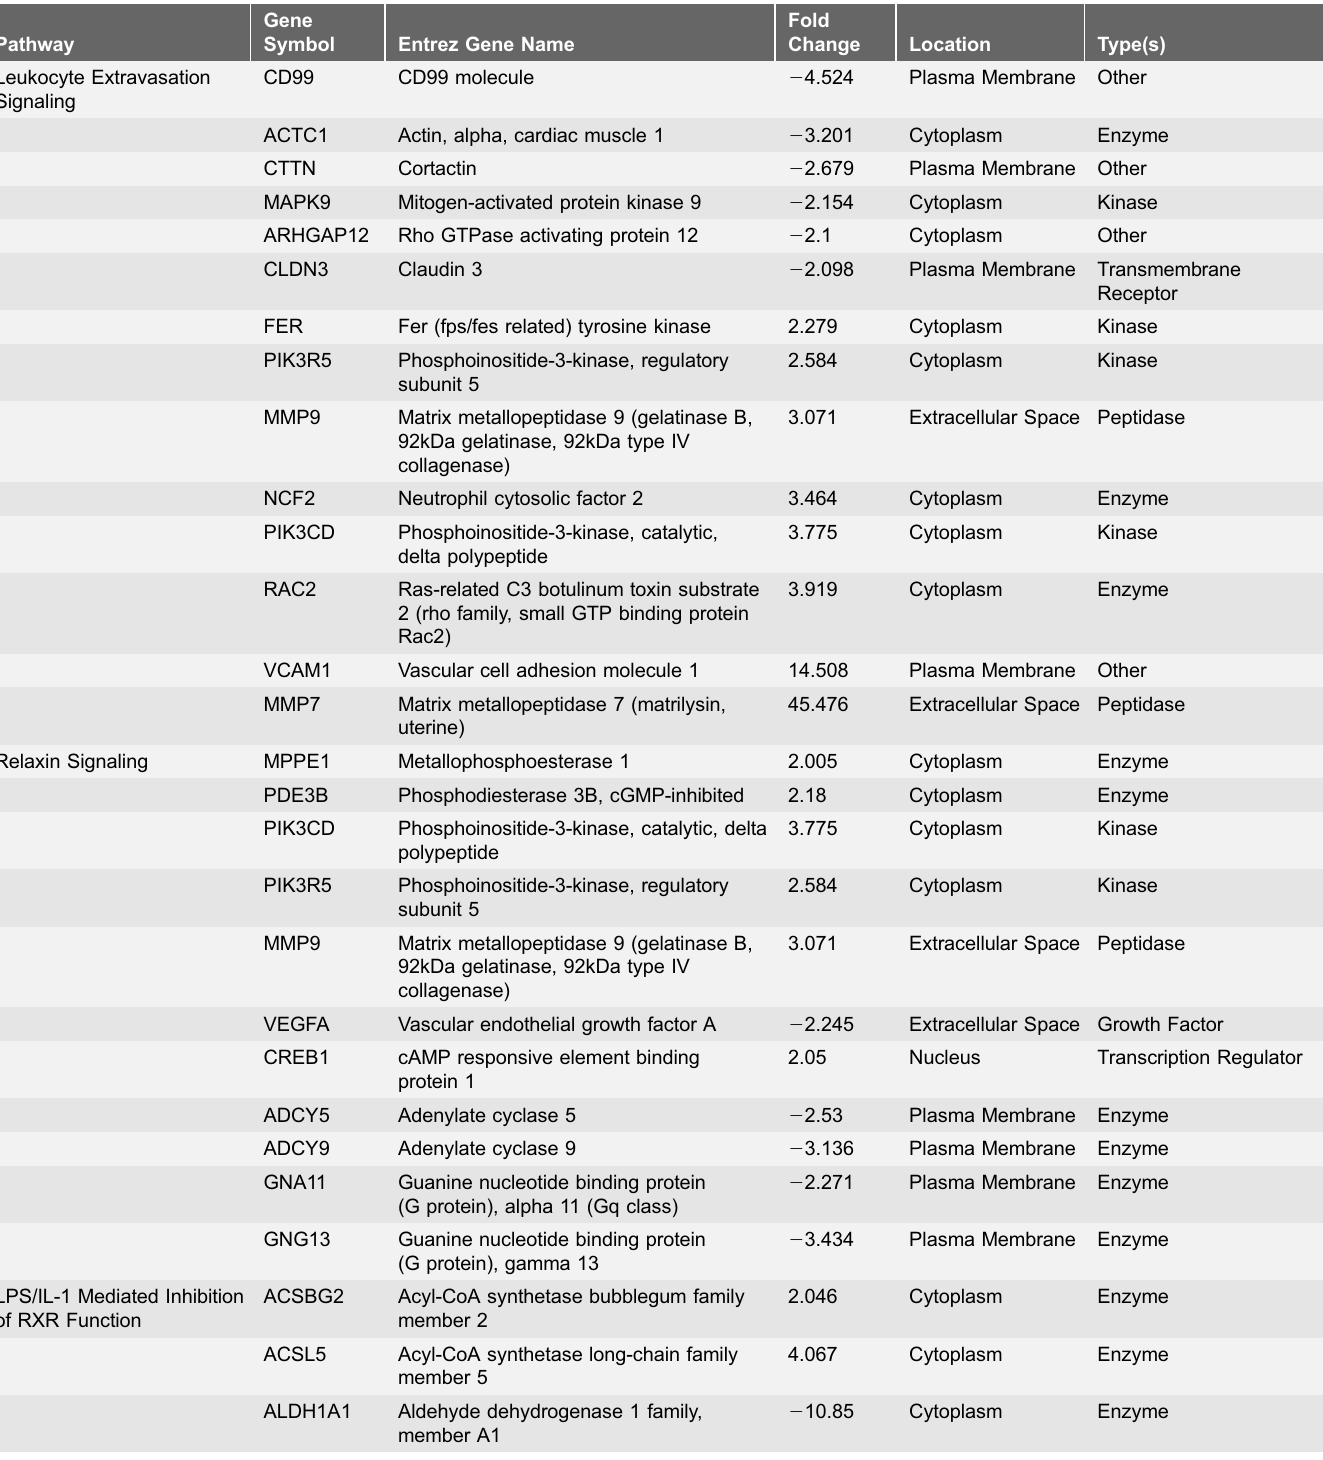
Table 5. Genes included in the three canonical pathways most significantly associated with the differentially expressed transcripts in C. perfringens / E. maxima co-infected Ross chickens compared with uninfected controls.